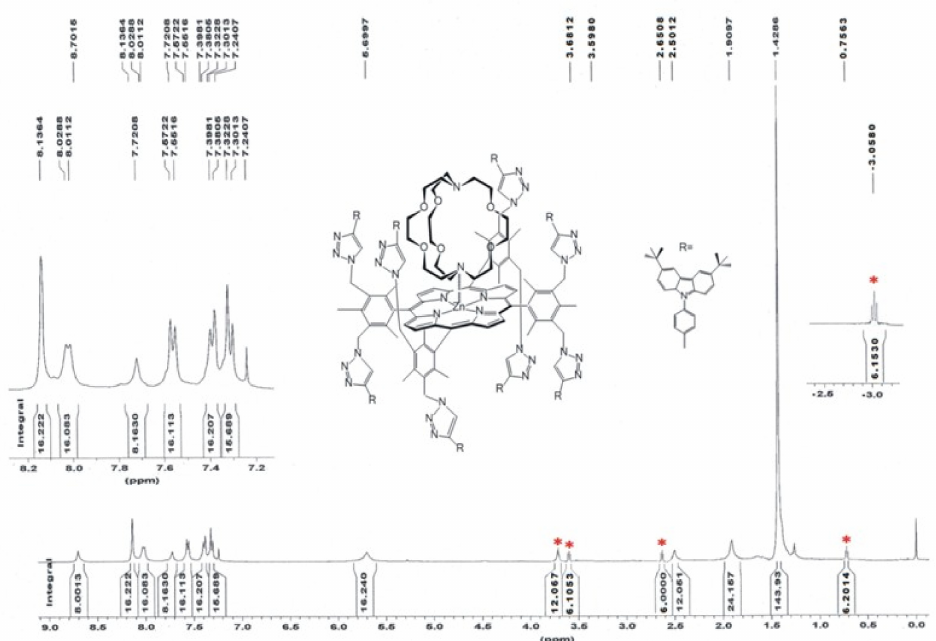
Figure 25. 1 H-NMR spectrum of the 79-Cr1 complex in CDCl 3 (300 MHz, 298 K); *—the signals of the equivalent (unsplit) central (-OCH 2 CH 2 O-, 12 H) protons, and nonequivalent (split) lateral [-OCH 2 -, (6H + 6H), and -CH 2 N-, (6H + 6H)] protons of the Cr1.